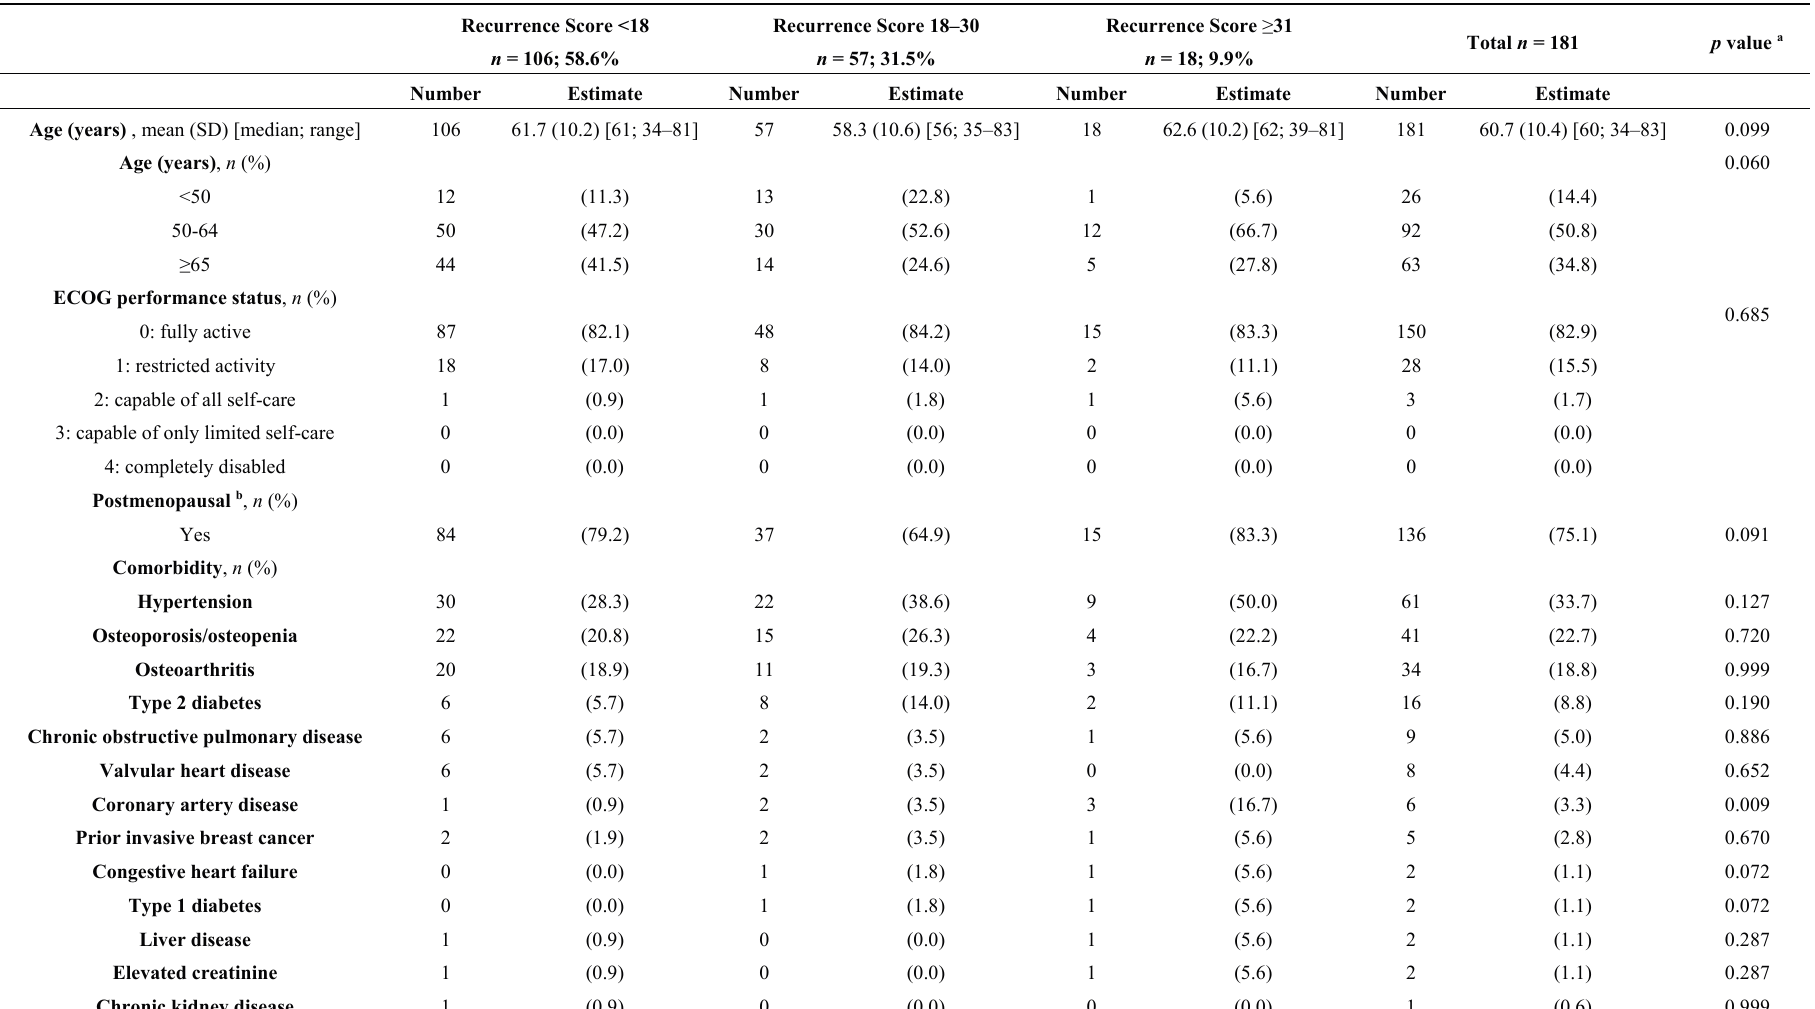
Table 1. Patient characteristics and medical history by Recurrence Score result